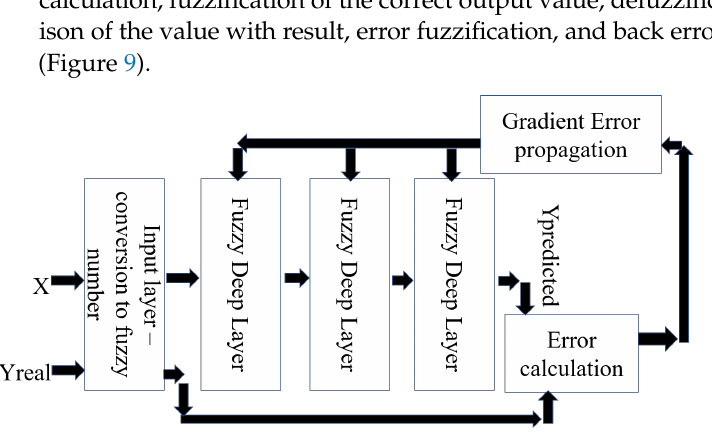
Figure 9. Fourth learning